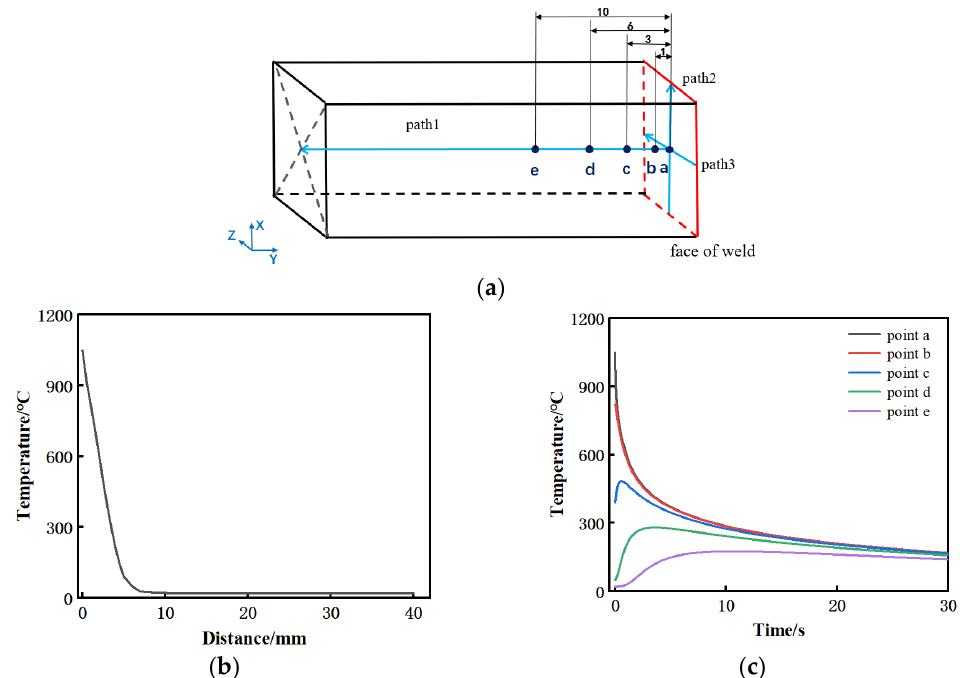
Figure 7. Temperature distribution during the cooling process: ( a ) Schematic diagram of path and key points; ( b ) temperature distribution along path 1 when cooling starts; ( c ) temperature time curve of key points in early cooling period (within 30 s).